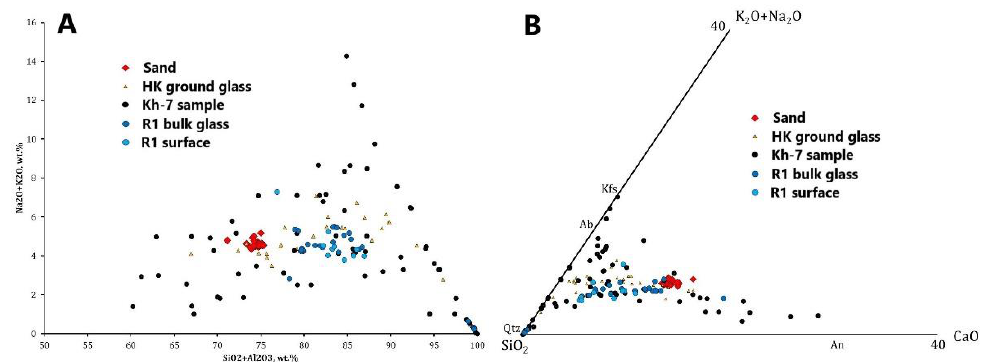
Figure 13. Chemical composition of samples from the studied groups in comparison with local sand. Representative points are shown. ( A ) part of a ternary diagram sum of alkalis (Na 2 O+K 2 O) – sum of SiO 2 and Al 2 O 3 . ( B ) SiO 2 corner of SiO 2 -CaO-alkalis ternary. The maximal pressure exerted by the blast on the soils appears to be rather